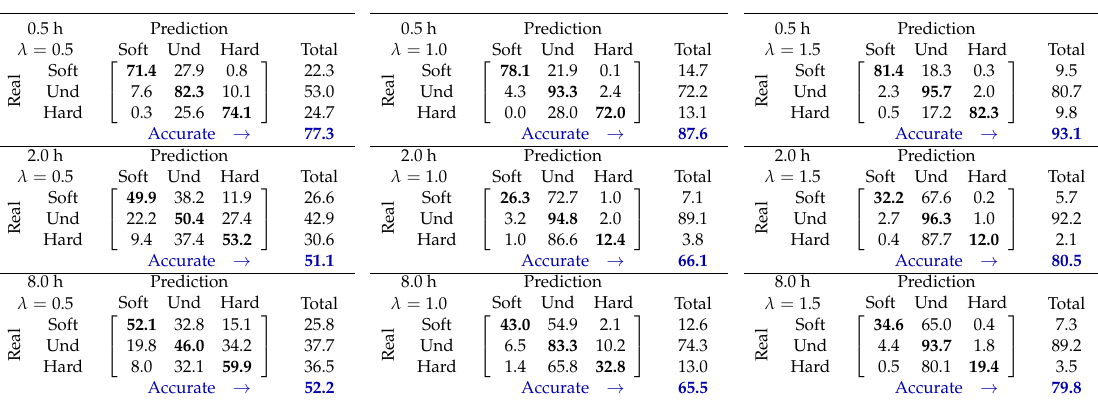
Table 6. SAG mill 1. Confusion matrices (percentage) of ORH prediction using λ : 0.5, 1.0 and 1.5 at 0.5, 2 and 8 h time supports.